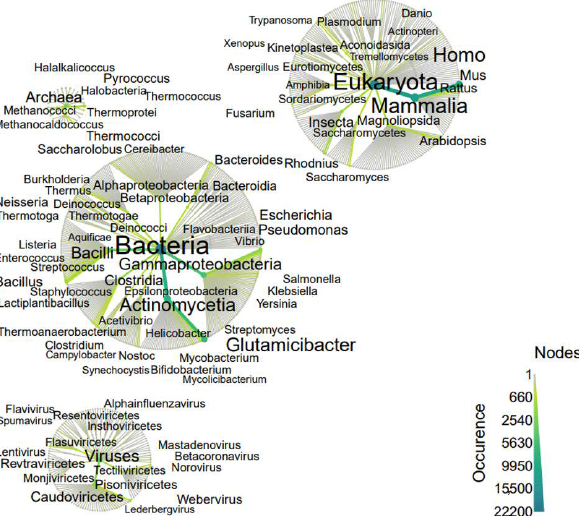
Figure 6. Origin of proteins in which 3 β -corners have been identified. The taxonomic community is revealed by a heat tree map, showing the taxonomic context from higher ranks in the center to lower ranks in peripheries (kingdom to class). The abundance of species (occurrence) can be quantified and visualized by color and size of the nodes and edges. Graph components, such as the size and color of text, nodes and edges, allow for the quantitative representation of multiple statistics simultaneously. Each node represents a taxon, and the edges determine where the taxon fits within the overall taxonomic hierarchy.